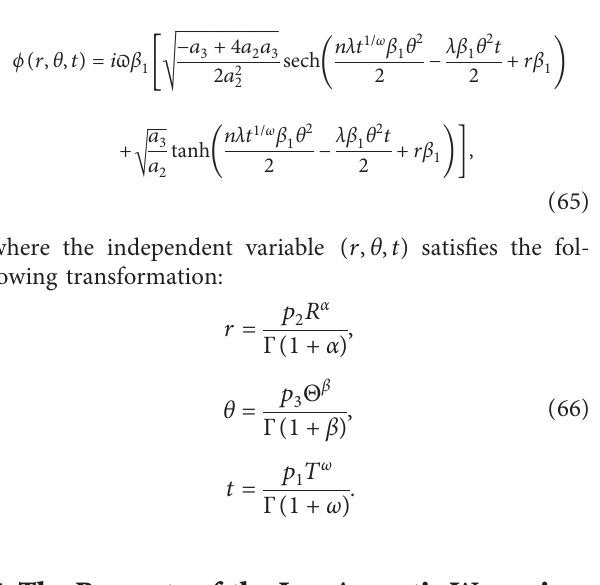
� 1 . 2, β � 1 . 4, ω � 1, and ϖ � 1. (b) β 1 3 � 1 . 2, β � 2, ω � 1, and ϖ � 1 3